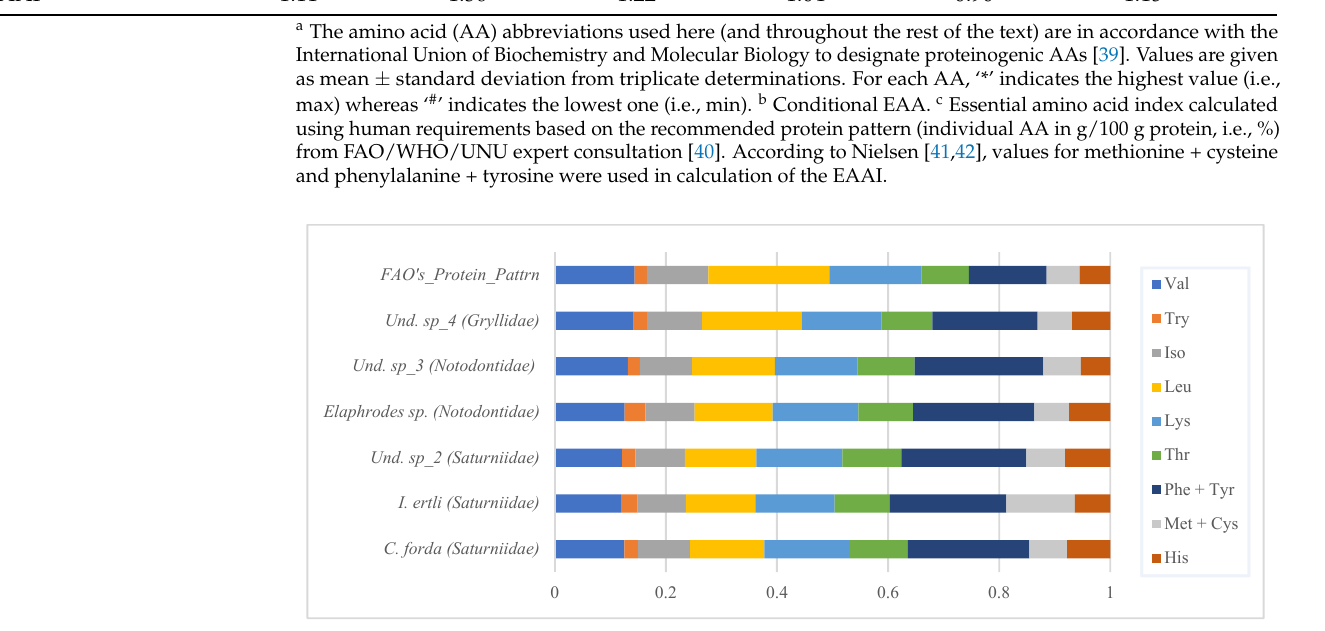
Figure 2. Comparison of EAA distribution in the protein fraction (% of total AAs) of six selected edible insects to protein pattern (individual AAs in g/100 g protein, i.e., %) based on recommendation by the FAO [40].